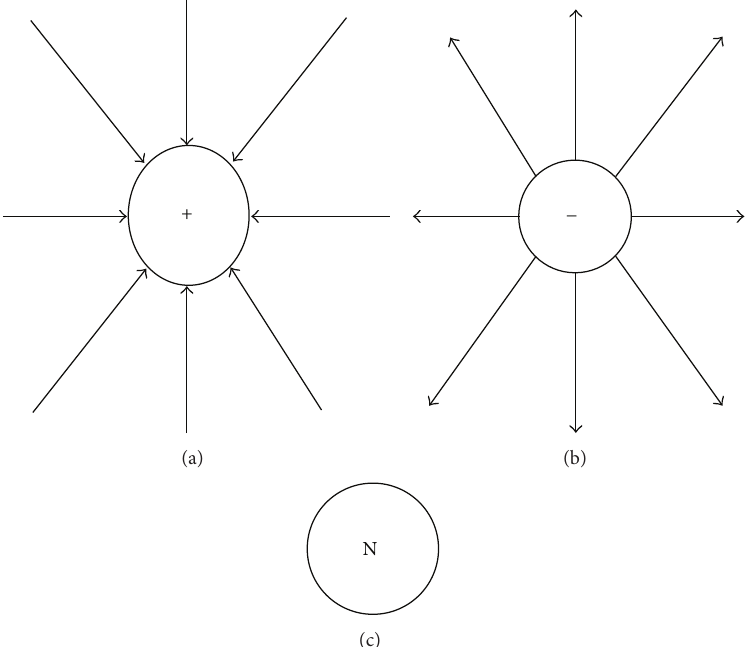
Figure 2: Three forms of charge in the